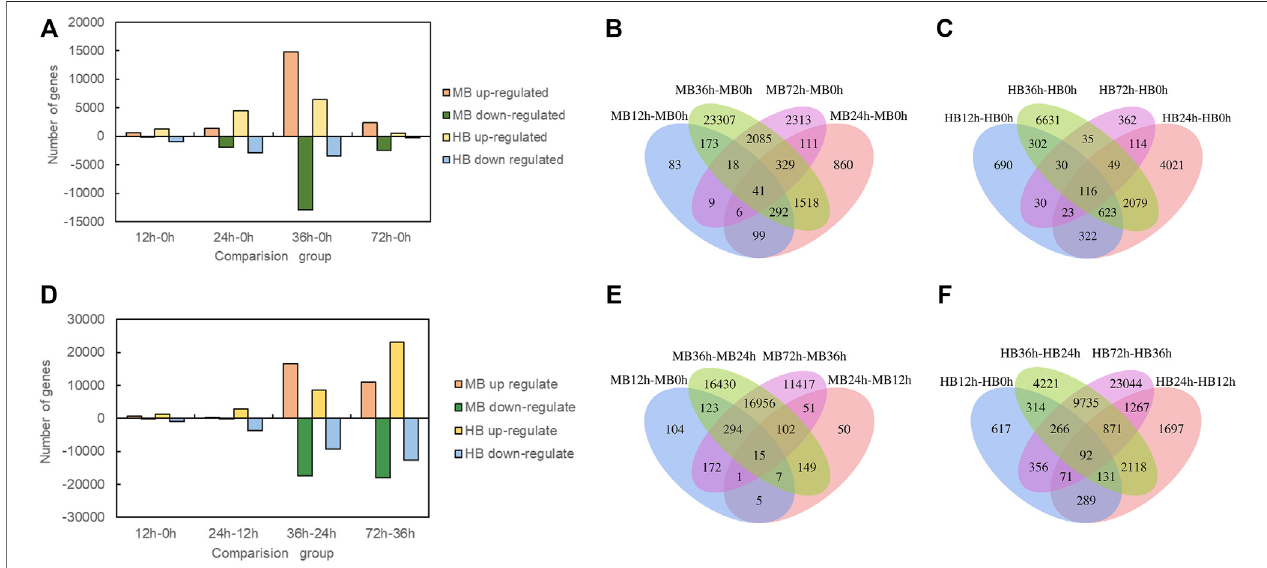
FIGURE 3 | Differentially expressed genes statistics at different time point ’ s comparison. (A) Number of up regulated and down regulated DEGs ( p adj < 0.05) statistics for four comparisons (12 vs. 0 h; 24 vs. 0 h; 36 vs. 0 h; 72 vs. 0 h) in MB group and HB group. MB represents plants were pre-treatment with melatonin and then inoculated with B. elliptica ; HB represents plants were pre-treatment with Milli-Q water [ethanol/water (v/v) D 1/10,000], and then inoculated with B. elliptica . (B) VenndiagramillustratethenumberofDEGsinfourcomparisons (12vs.0 h;24vs.0 h; 36vs. 0 h;72vs.0 h)overlappinginMBgroup,MBrepresentsplants were pre-treatment withmelatonin and then inoculated with B.elliptica ; (C) Venndiagramillustrate thenumber ofDEGsinfourcomparisons (12vs. 0 h; 24vs. 0 h; 36vs.0 h; 72vs.0 h)overlappinginHBgroup,HBrepresentsplantswerepre-treatmentwithMilli-Qwater[ethanol/water(v/v)D1/10,000],andtheninoculatedwith B.elliptica ; (D) Number of up regulated and down regulated DEGs ( p adj < 0.05) statistics for four comparisons (12 vs. 0 h; 24 vs. 12 h; 36 vs. 24 h; 72 vs. 36 h) in MB group and HB group. MB represents plants were pre-treatment with melatonin and then inoculated with B. elliptica ; HB represents plants were pre-treatment with Milli-Q water [ethanol/water(v/v)D1/10,000],and theninoculatedwith B. elliptica. (E) Venndiagram illustrate thenumber ofDEGsinfour comparisons (12 vs.0 h; 24vs. 12 h;36vs. 24 h; 72vs. 36 h)overlappingin MBgroup, MBrepresentsplants were pre-treatment withmelatonin and then inoculated with B. elliptica. (F) Venndiagram illustrate the number of DEGs in four comparisons (12 vs. 0 h; 24 vs. 12 h; 36 vs. 24 h; 72 vs. 36 h) overlapping in HB group, HB represents plants were pre-treatment with Milli-Q water [ethanol/water (v/v) D 1/10,000], and then inoculated with B. elliptica